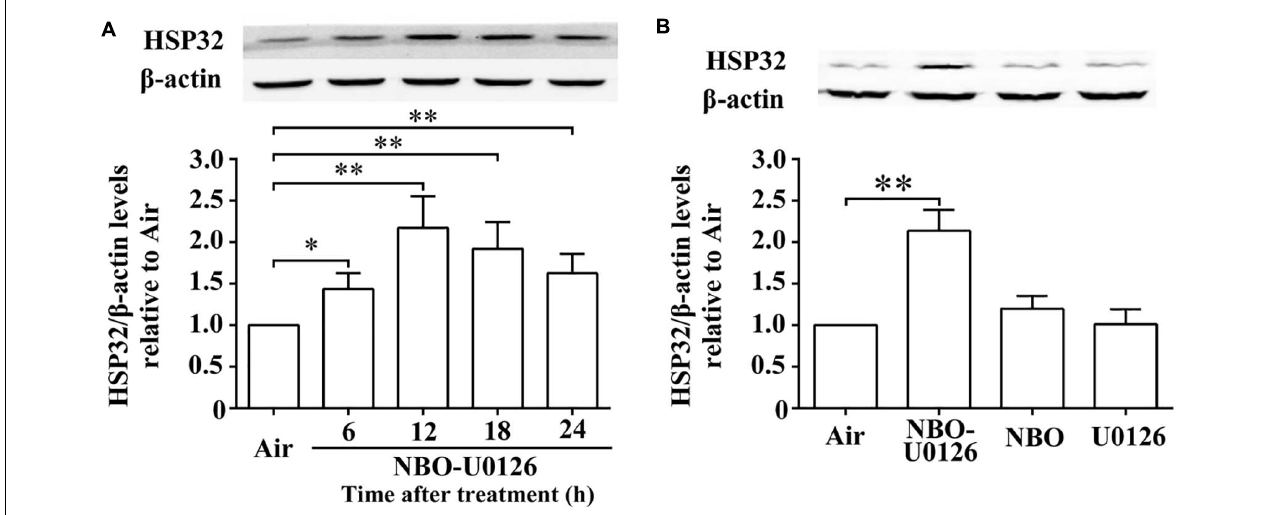
FIGURE 2 | Effects of NBO-U0126 on the expression of HSP32 in rat spinal cord. Rats were exposed with NBO and/or U0126, and spinal cord HSP32 was determined at designated times following treatment. (A) Time course expression of HSP32 ( n = 6). (B) HSP32 expression at 12 h with different treatments ( n = 6, the original image see in Supplementary Material ). ∗ P < 0.05, ∗∗ P <